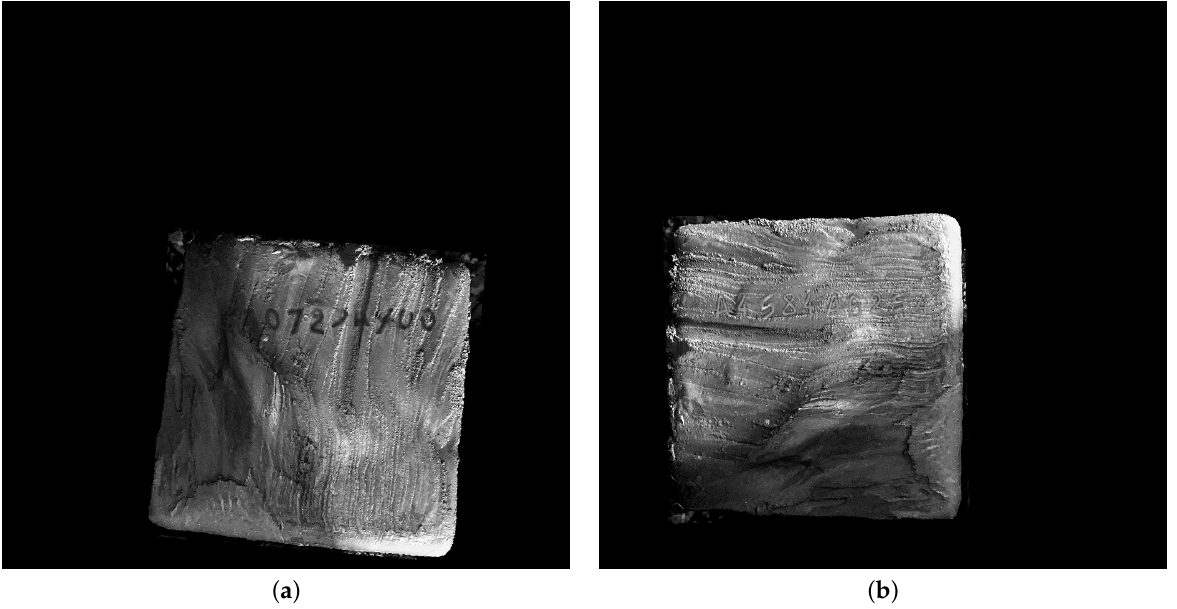
Figure 9. Two examples of synthetic training images with ( a ) and without ( b ) some only partially visible